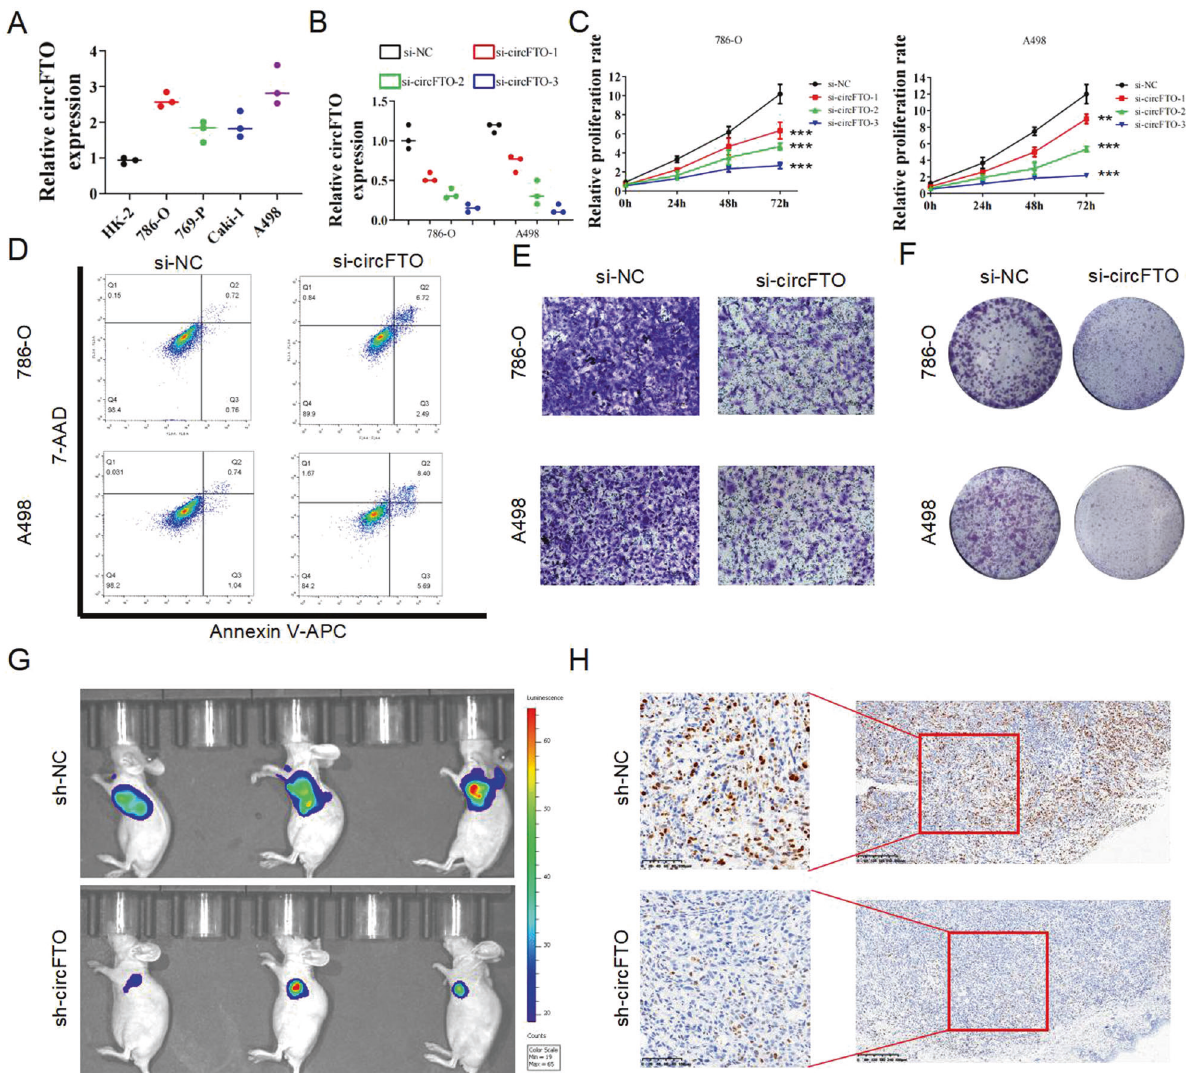
Fig. 2 circFTO silencing suppresses ccRCC cells proliferation and invasiveness in vitro and in vivo. A Relative expression of circFTO in four renal carcinoma cell lines (786-O, 769-P, Caki-1 and A498) and the immortalized normal kidney cell line HK-2 identi fi ed with qRT-PCR. B Relative expression of circFTO in 786-O and A498 cells after transfected with si-circFTO with qRT-PCR. C CCK-8 assay, ( D ). apoptosis assay, ( E ) transwell assay and ( F ) colony formation assay of 786-O and A498 cells after transfected with si-circFTO and negative control. G Subcutaneous xenografts of sh-NC and sh-circFTO luciferase (luc)-labeled 786-O cells identi fi ed with live imaging. H Ki-67 staining of the eviscerated